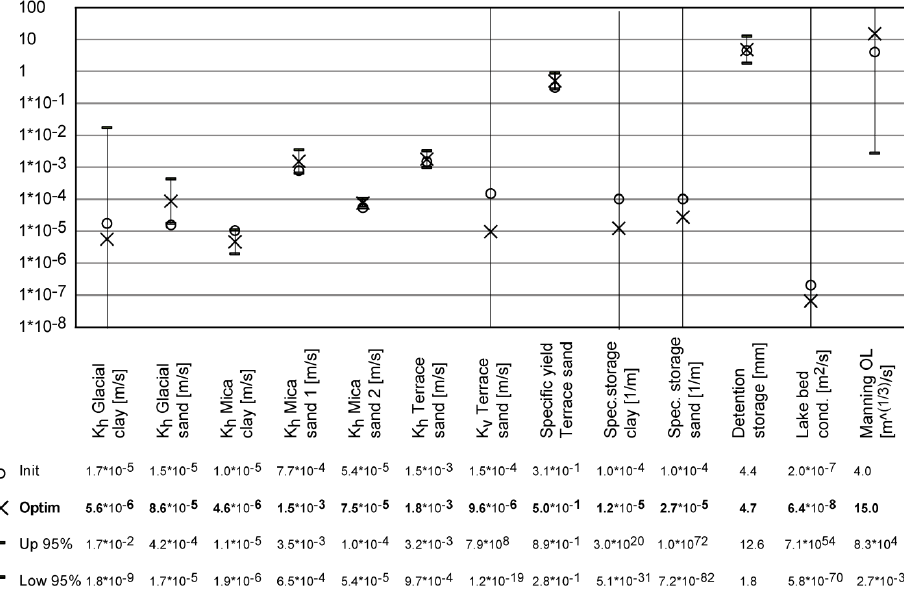
DC dataset are 9 series of 20 annual maxima-future